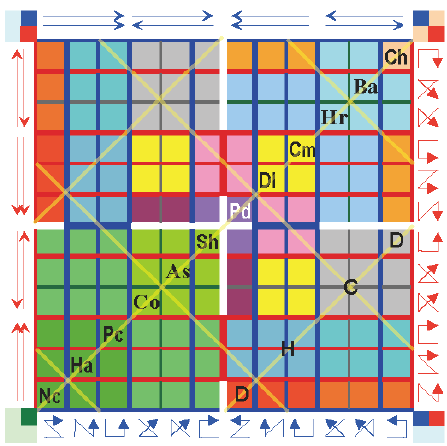
Figure 2. The twelve strict symmetric games form a diagonal axis in this small schematic diagram of the Topology of 2 × 2